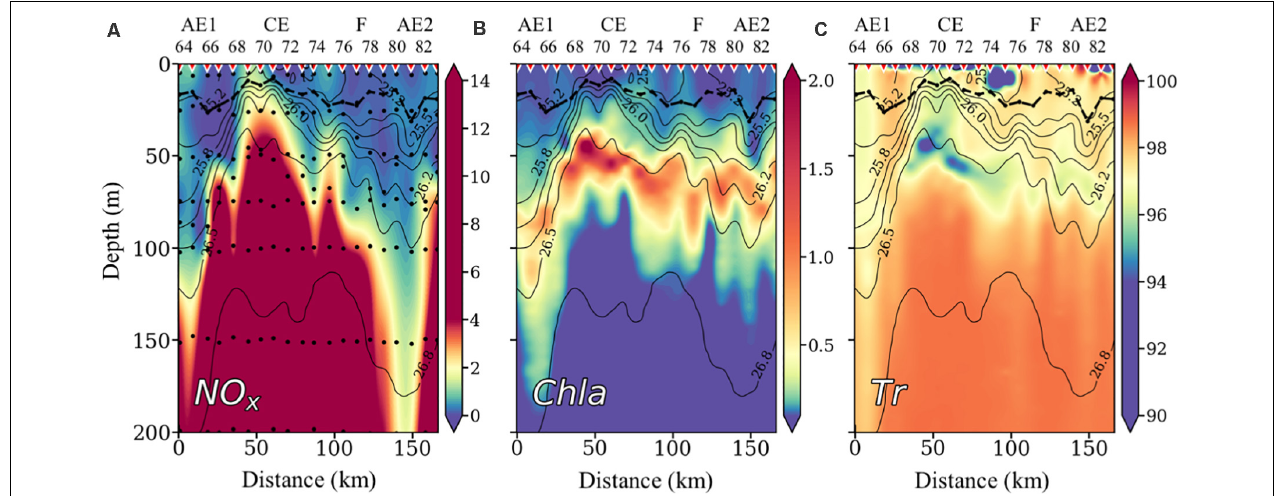
FIGURE 4 | Vertical distribution of nitrate + nitrite concentrations (NO x ) in µ M (A) , chlorophyll a (Chl a ) in µ g · L − 1 (B) , and Transmittance (T) in % (C) , with isopycnals superimposed. Inverted red triangles on the top axis indicate stations position. The locations of the anticyclonic eddies (AE), the cyclonic eddy (CE), and the filament (F) are also indicated on the top axis. The bold black line shows the depth of the mixed layer (MLD). Black dots indicate sampled